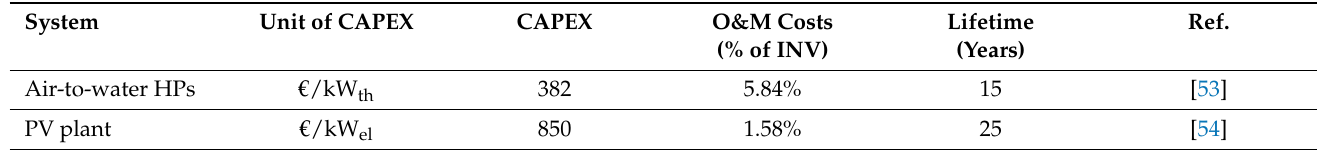
Table 4. Assumptions on capital expenditure (CAPEX), operation and maintenance (O&M) costs,